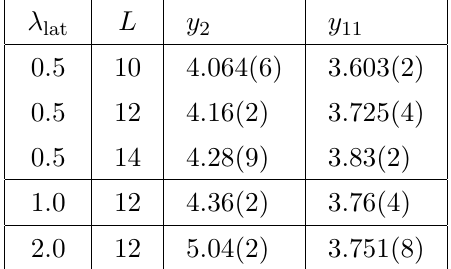
Table 2. Scaling dimension y k = 2 / (1 + γ eff ) obtained from eq. (3.12) for U(2) ensembles using the corresponding L = 16 results for reference. The two estimates consider the average second and eleventh eigenvalues,